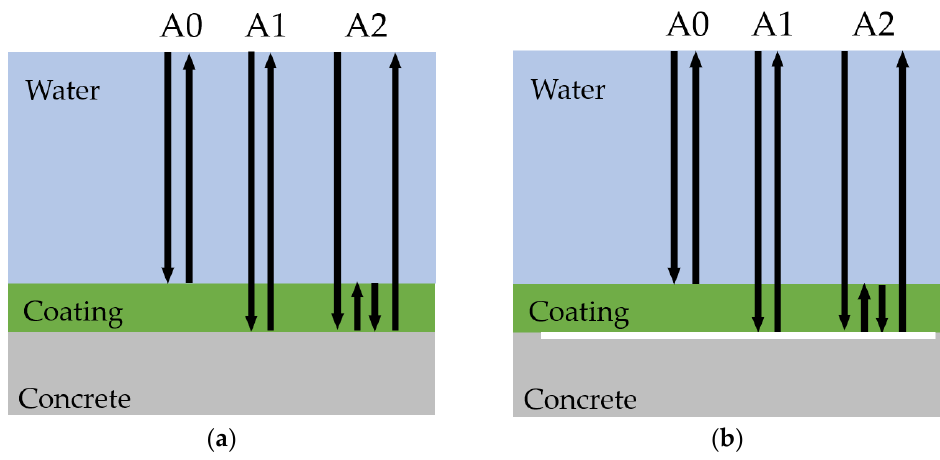
Figure 1. Schematic representation of the waveform propagation in a bonded coated layer ( a ) and a debonded coating layer ( b ).